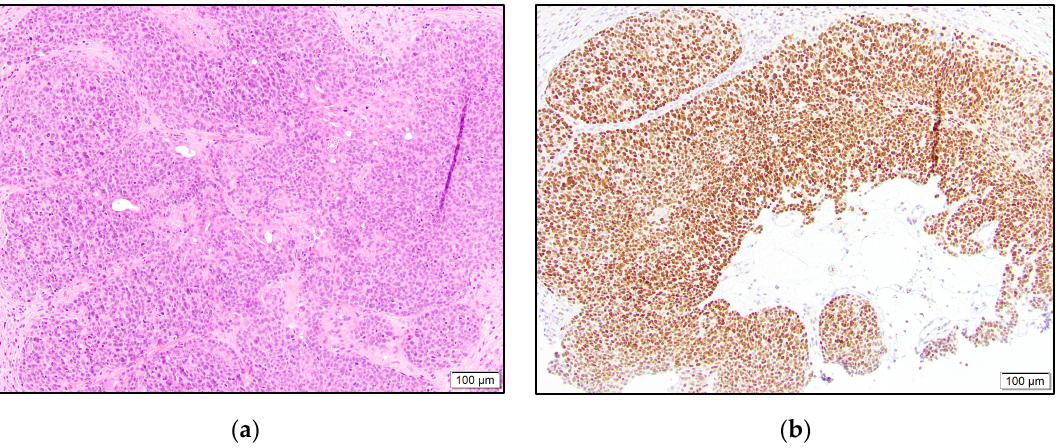
Figure 2. Hidradenocarcinoma with dermal tumor nodule composed of eosinophilic cells and mitoses ( a ) and high positive TRPS1 expression ( b ).